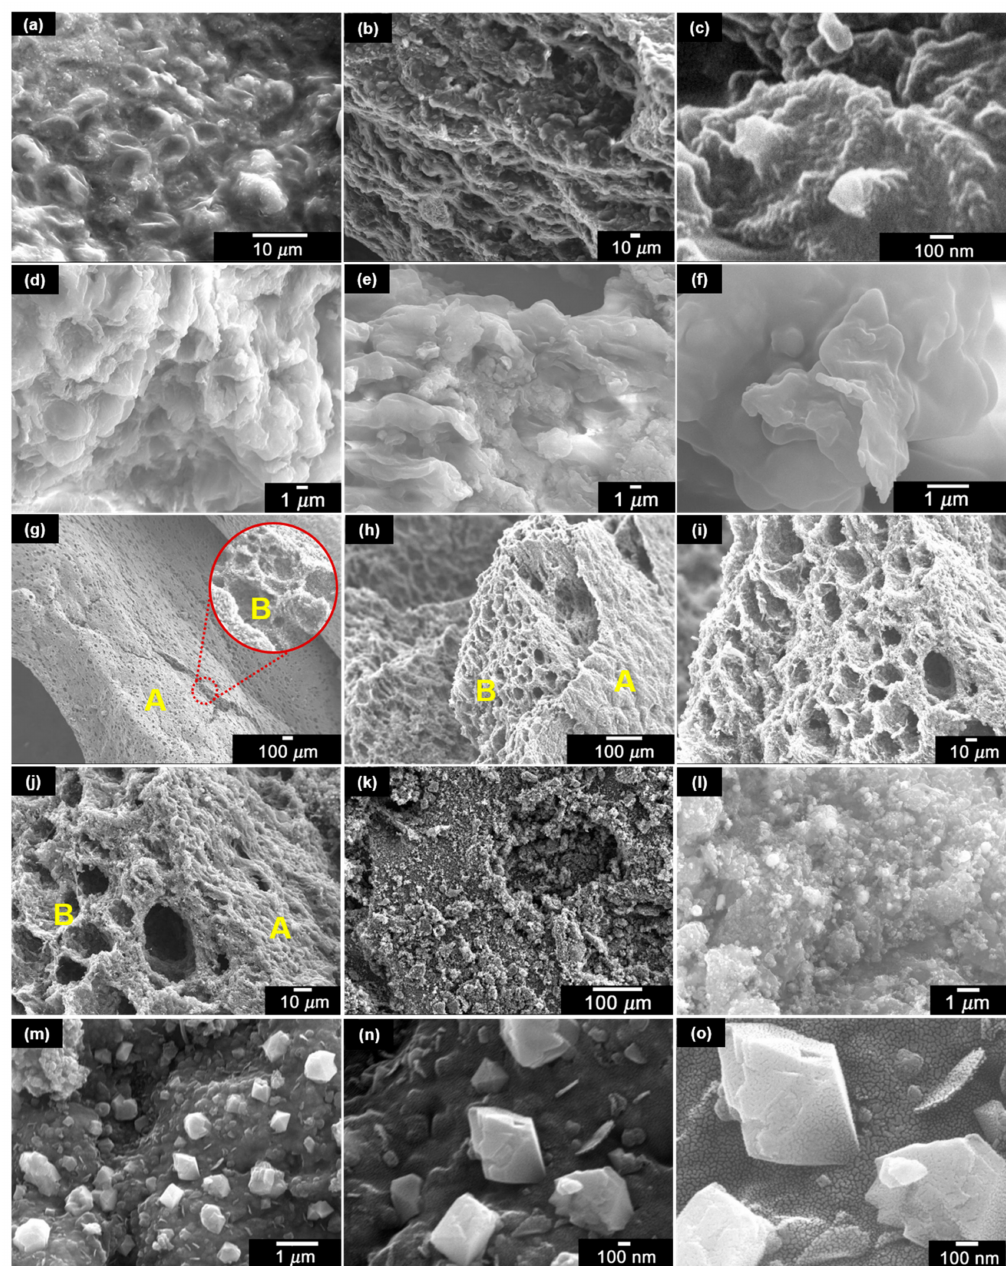
Figure 1k–l is the SEM images of the carbonized B. braunii residues in the powder form. The grinding process before carbonization destroyed the multilayer structure, and no obvious pores were observed. Magnification reveals a large amount of polygonal crystals well imbedded in the sample. Some crystals are regular octahedrons with side length of 600 nm to 1 µ m (Figure 1m–o). These crystals were not observed in the samples without carbonization.